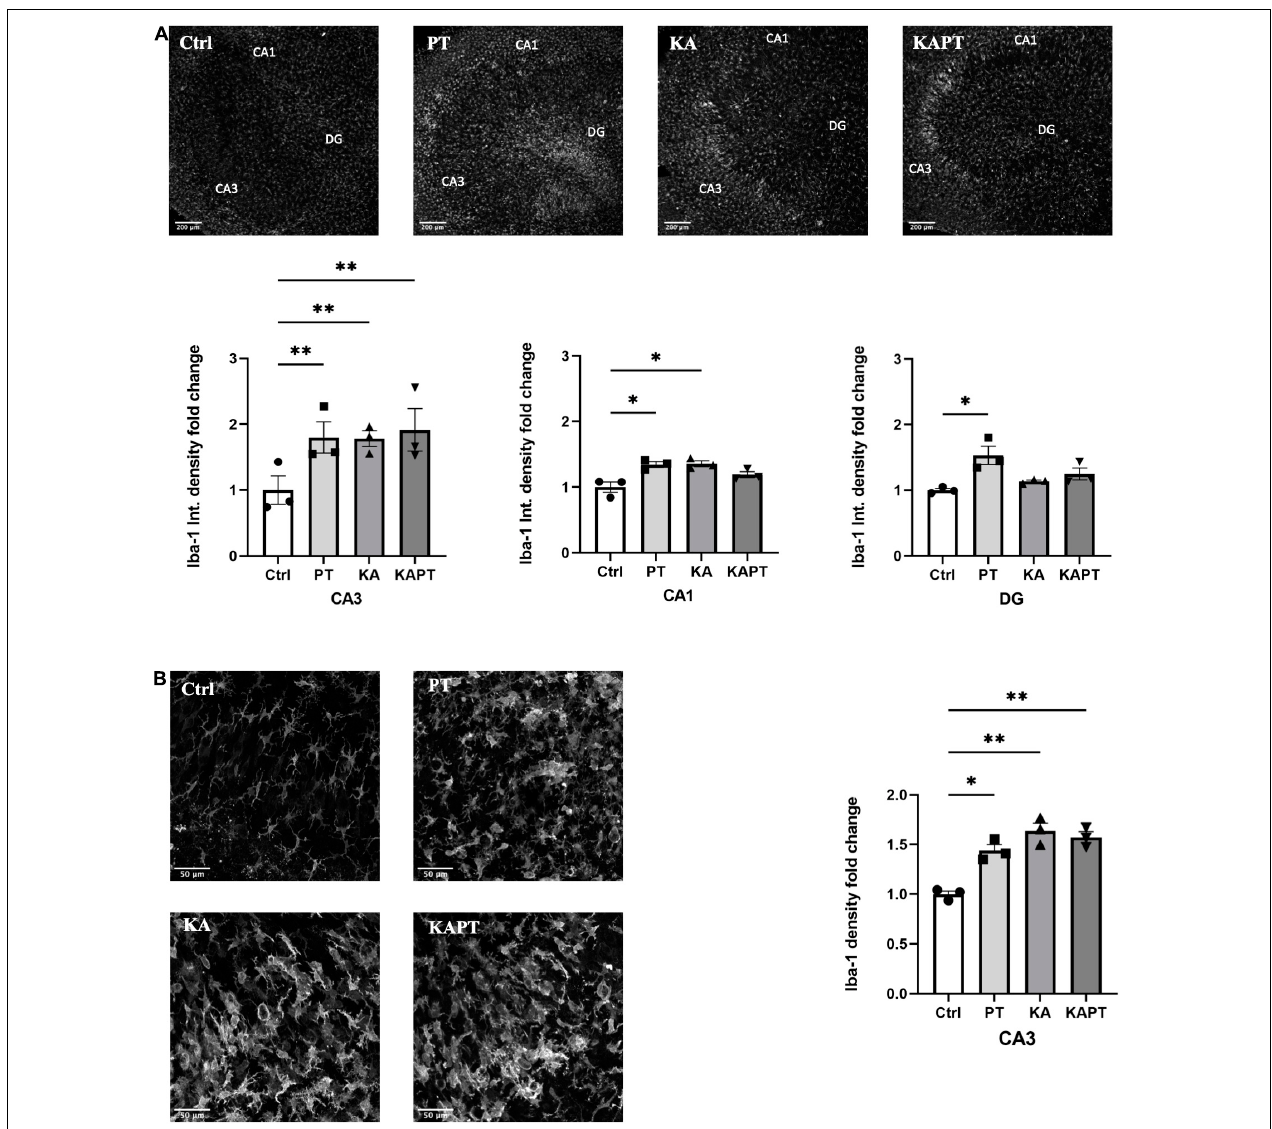
FIGURE 4 | Platinum nanoparticles (PtNPs) cause microglia activation in organotypic hippocampal slices after 24 h of contact. (A) Representative Iba-1 immunostaining of organotypic hippocampal slices under control conditions, PtNPs, kainic acid (KA) treatment, and KA treatment + PtNPs. Bottom charts represent the quantitative analysis of Iba-1 fluorescence intensity in CA3, CA1, and dentate gyrus (DG). (B) Magnified images of Iba-1 stained microglia at the level of the CA3 region, showing altered morphology of cells in all the treatment groups compared to the control. Right chart represents Iba-1 density quantification at the CA3 region for all experimental groups. Data are expressed as Iba-1 fluorescence intensity and density fold change from the value of control slices and presented as means ± standard error of the mean (SEM) ( n = 3 independent experiments; 4–6 slices analyzed per group/experiment). Tukey’s test after one–way analysis of variance (ANOVA) was used for statistical analysis. ∗ p < 0.05; ∗∗ p <